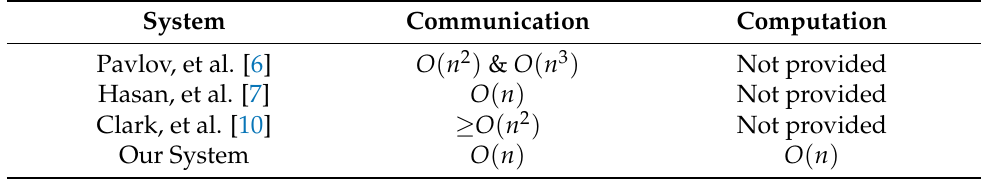
Table 4. The complexity of reputation